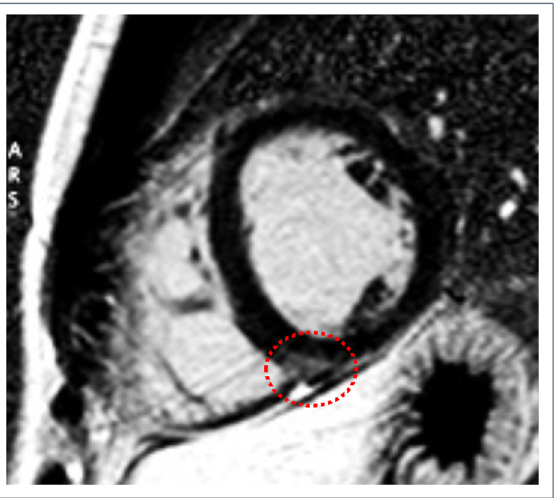
Figure 1. Post-contrast short-axis imaging of a healthy 25-year-old male competitive athlete with isolated RVIP fibrosis (dotted red circle) in the context of an otherwise normal CMR.